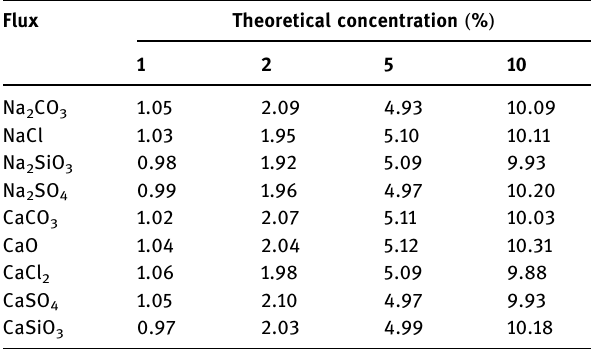
Table A1: Actual concentrations of fl ux in partial prepared